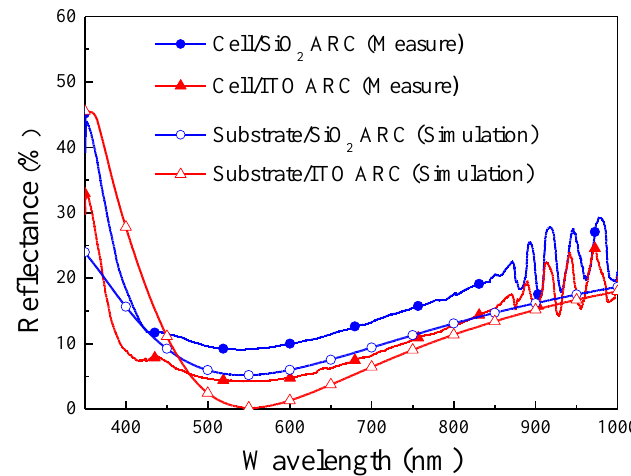
Figure 5. Measured optical reflectance and simulated optical reflectance of SiO 2 ARC and ITO ARC.